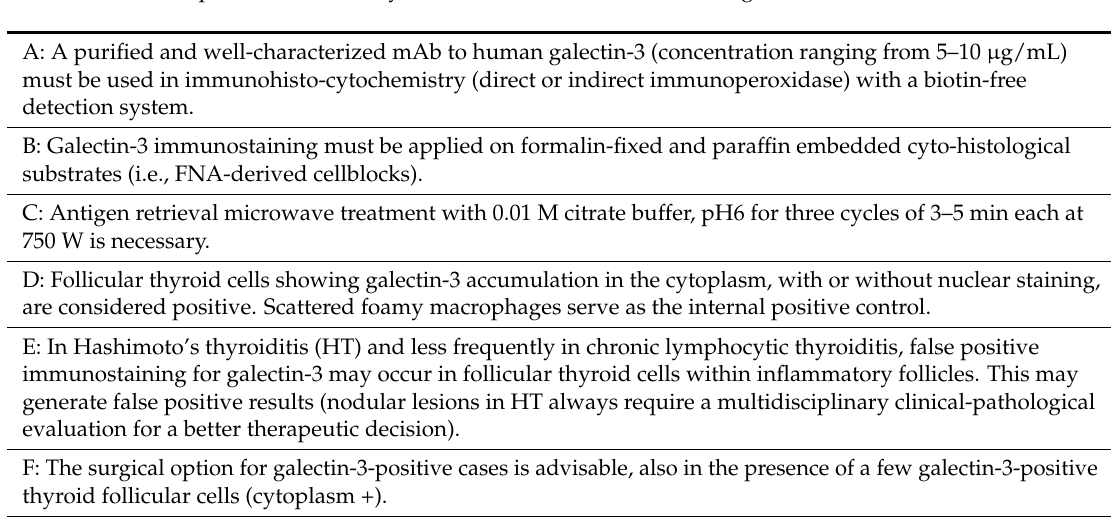
Technical requirements for galectin-3 expression analysis to be applied on fine-needle-aspiration-derived thyroid cells and conventional histological